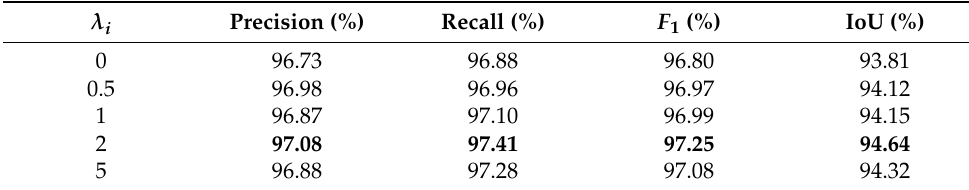
Table 5. Comparison of networks with different joint loss functions varying in weight on the AG dataset. λ i = 0 denotes that the network only implements segmentation task. The best entries are highlighted in bold.